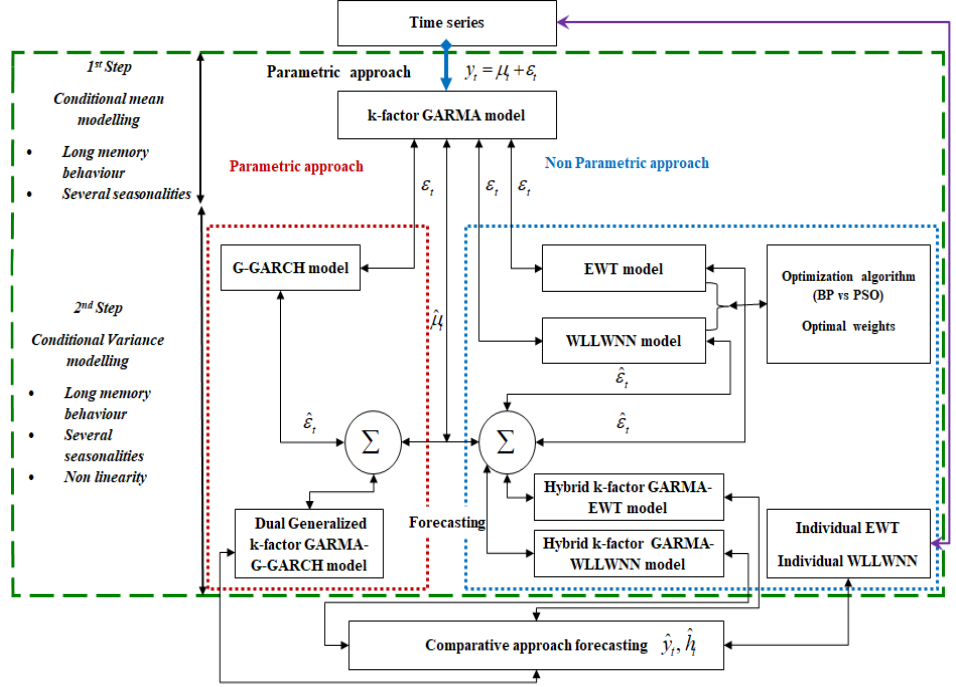
Figure 1. The implemented hybrid procedure.